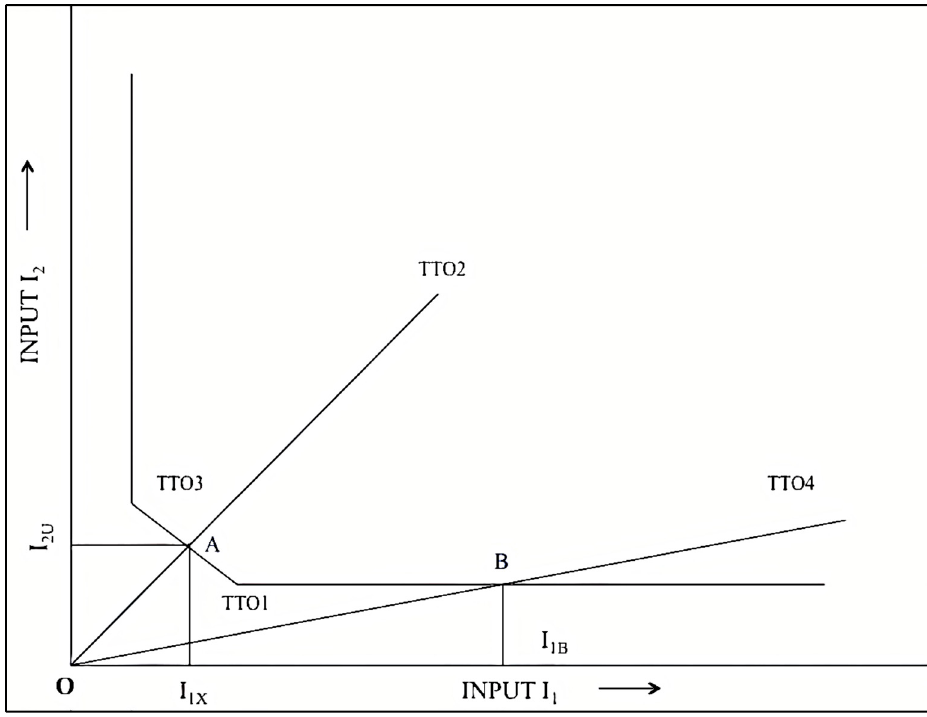
ffi ciency frontier of five technology transfer o ffi ces consuming two inputs. Figure 5. Efficiency frontier of five technology transfer offices consuming two inputs. Figure 5. E